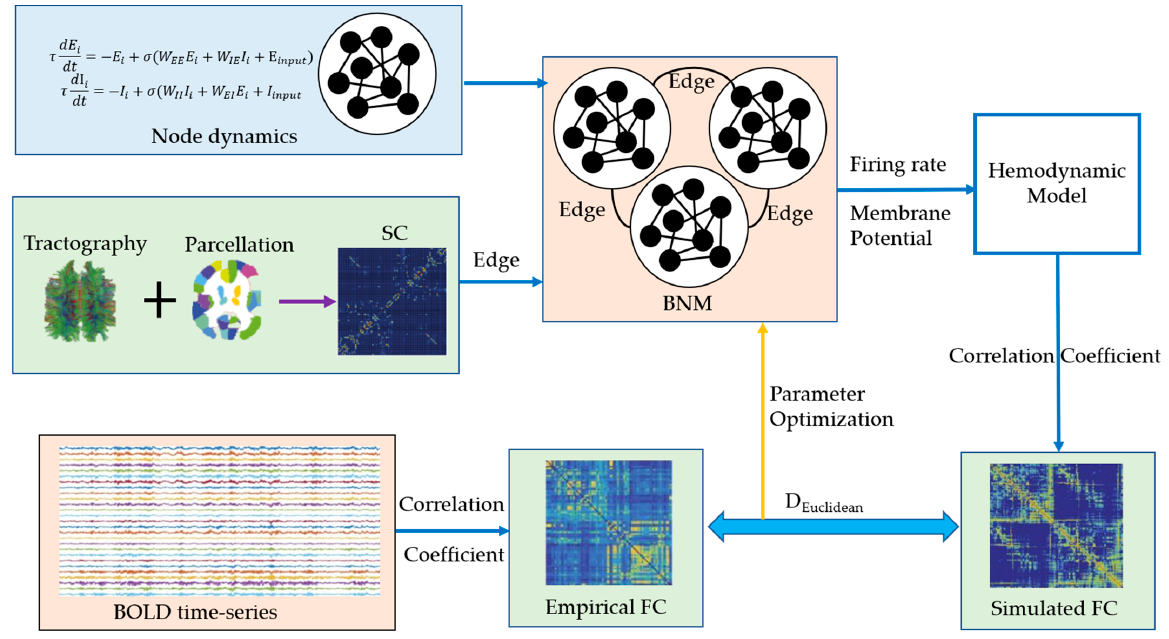
Figure 2. The pipeline for fitting BNMs to time-averaged FC. The node dynamics are modeled by neural mass models to output average firing rates or membrane potentials. SC is estimated by tractography combined with parcellation schema and acts as edges of brain networks. Then, the mesoscopic neuronal populations are connected by SC to simulate macroscopic spatiotemporal brain activity. The output of each node is fed into the hemodynamic model to simulate BOLD time-series, then correlation coefficients (such as Pearson’s correlation coefficient) in the whole-time interval are computed for time-series of each pair of nodes to construct time-averaged FC. The Euclidean distance is used to evaluate the similarity between empirical FC and simulated FC [53,66], based on which model parameters can be